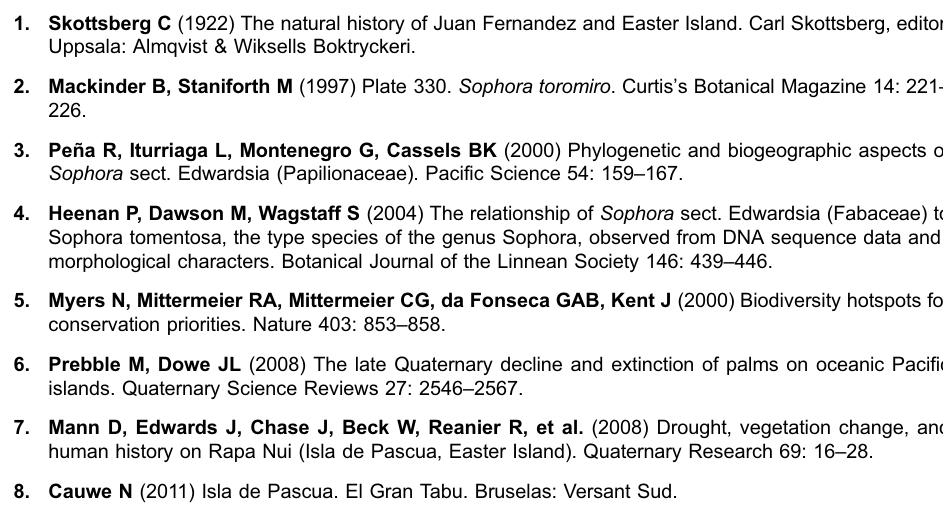
S1 Table. Description of the landmarks on the floral elements. S2 Table. Raw Coordinate values for the different flower structures and their corresponding